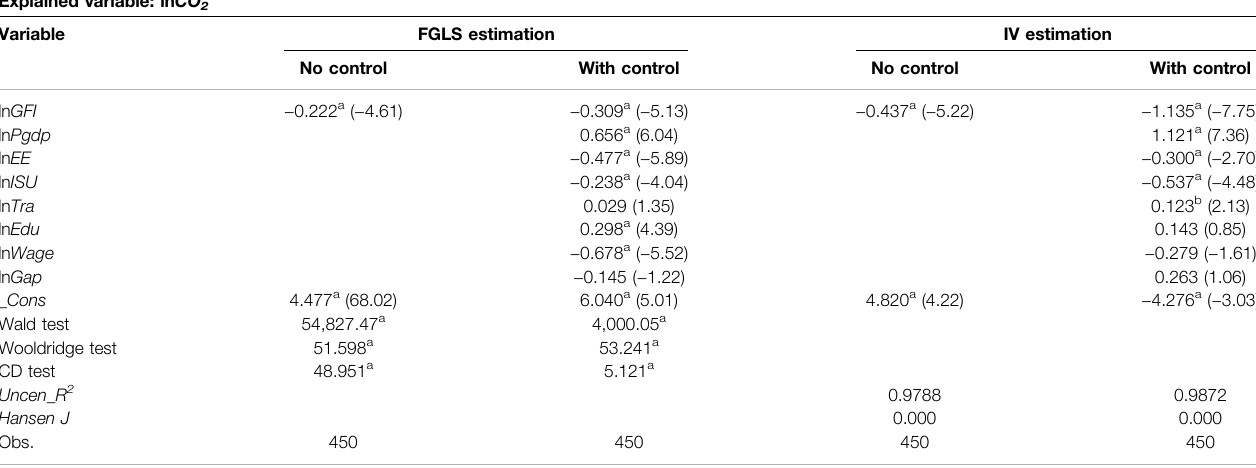
TABLE 3 | Estimated results of the impact of green fi nance on CO 2 emissions.